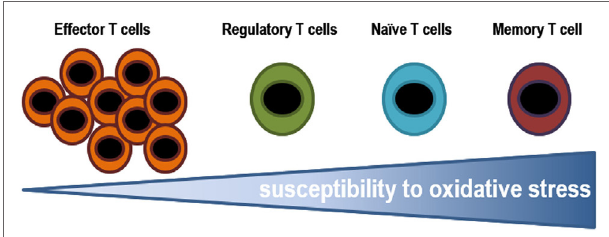
FiGURe 5 | Susceptibility of T lymphocytes to oxidative stress. Effector cells are exposed to low oxidative environment, while memory cells are T lymphocytes found in the most oxidative environments. The ability of T lymphocytes to stand such oxidative conditions, in either an infectious disease state or a tumor microenvironment, might determine the pool of T